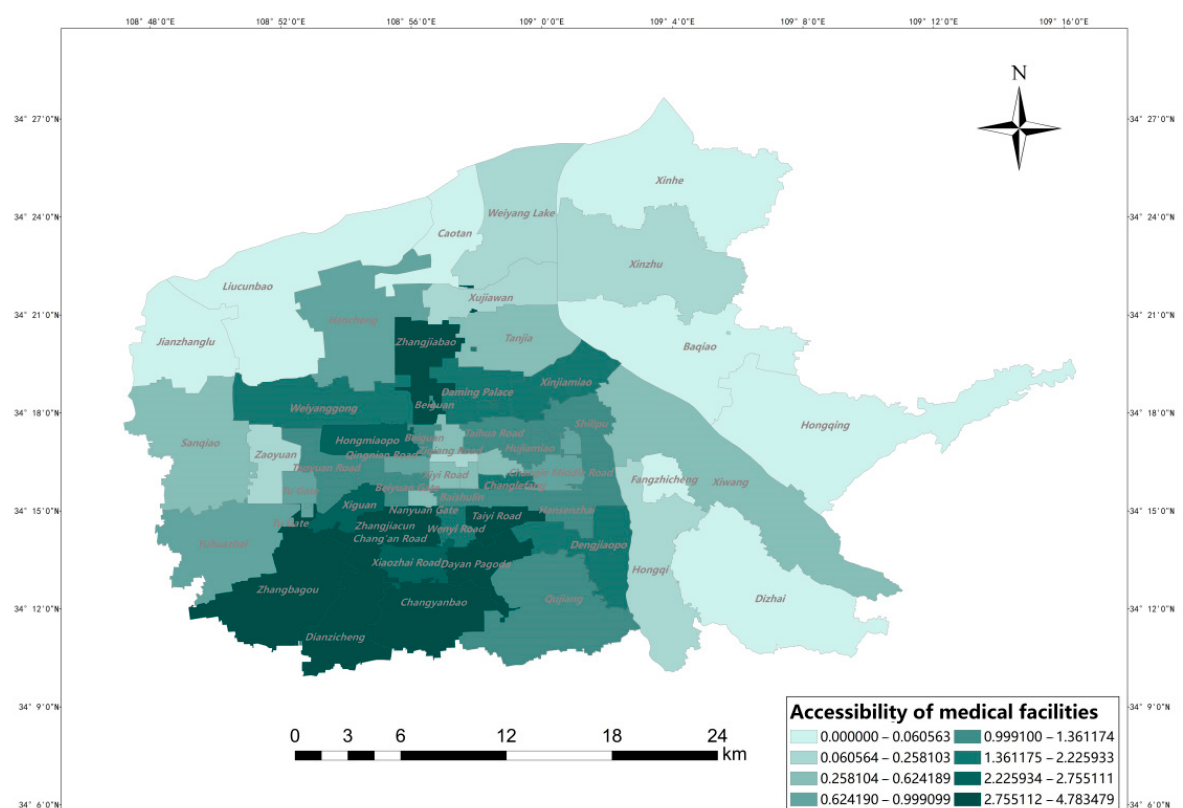
Figure 8. Accessibility of medical facilities.